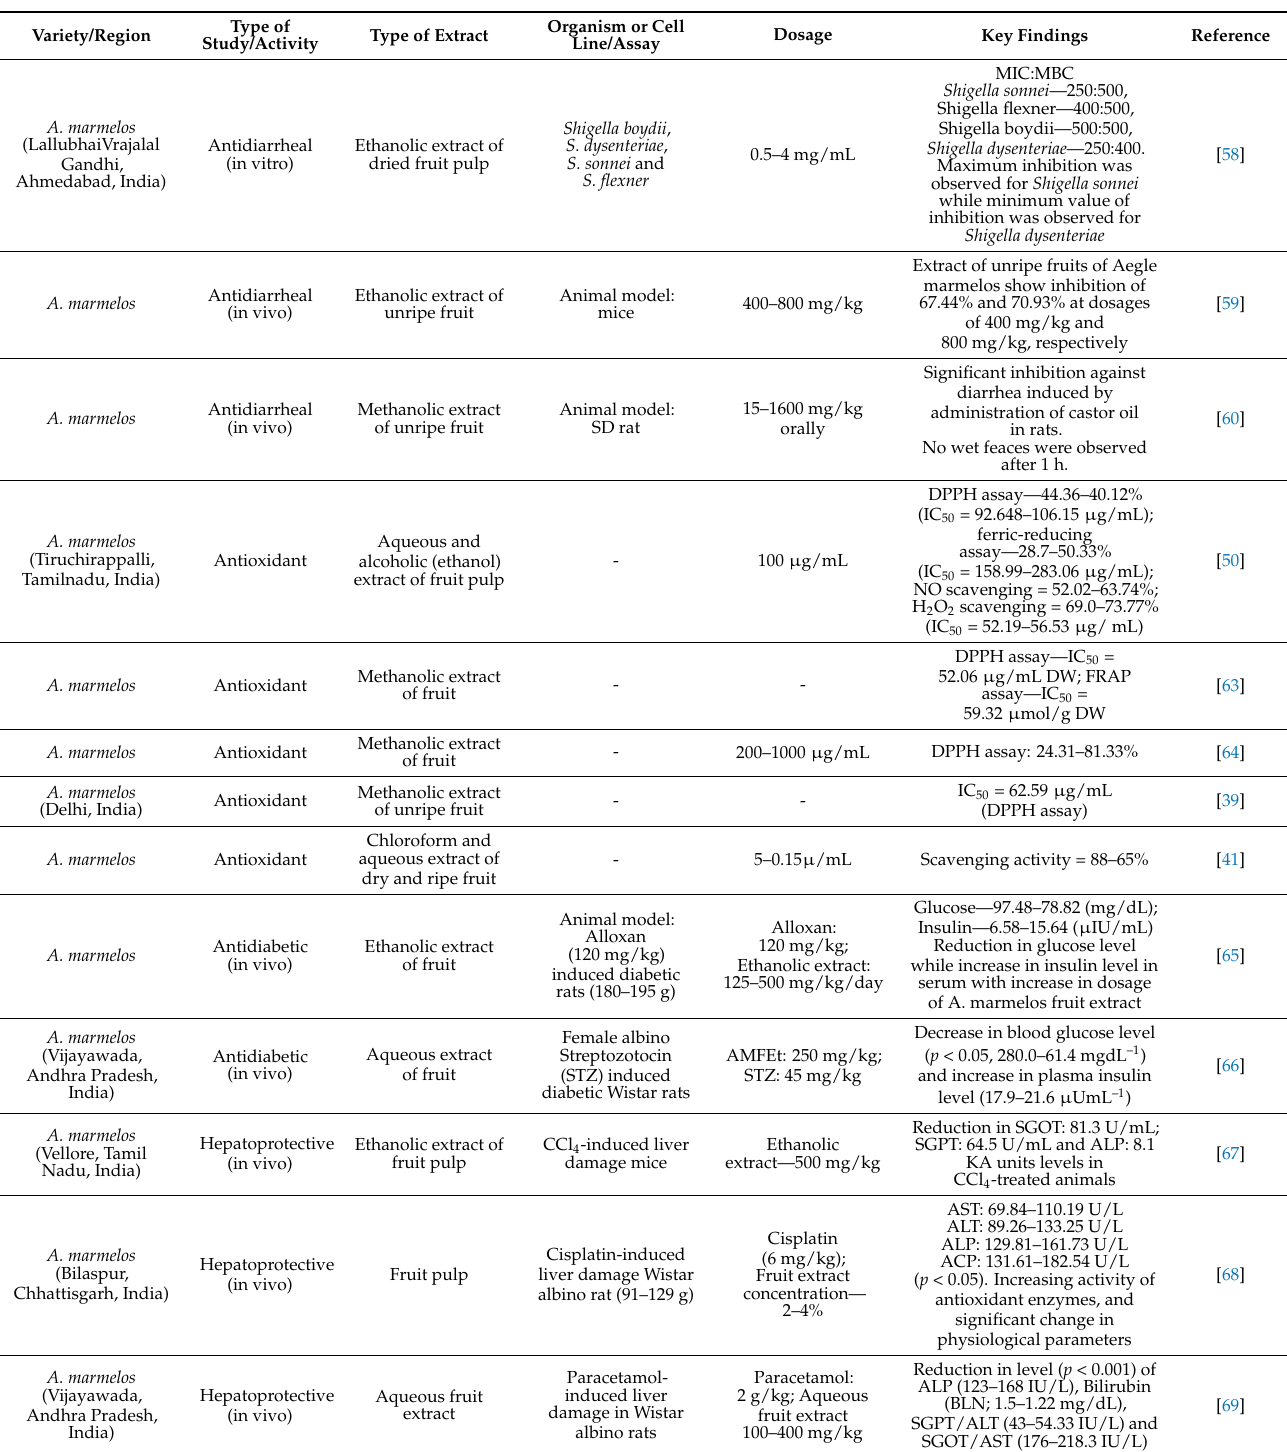
Table 3. Pharmacological activities of A. marmelos